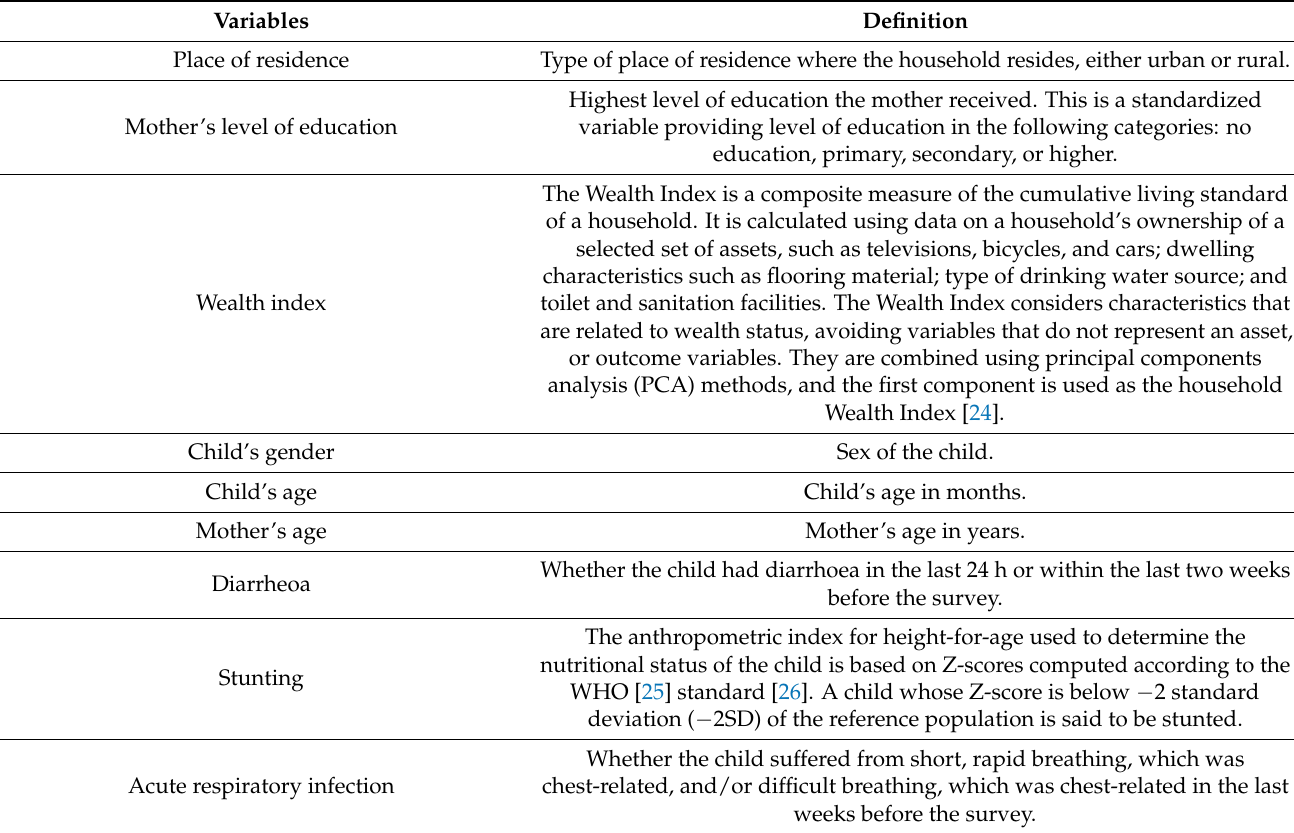
Table 1. Variables used for this